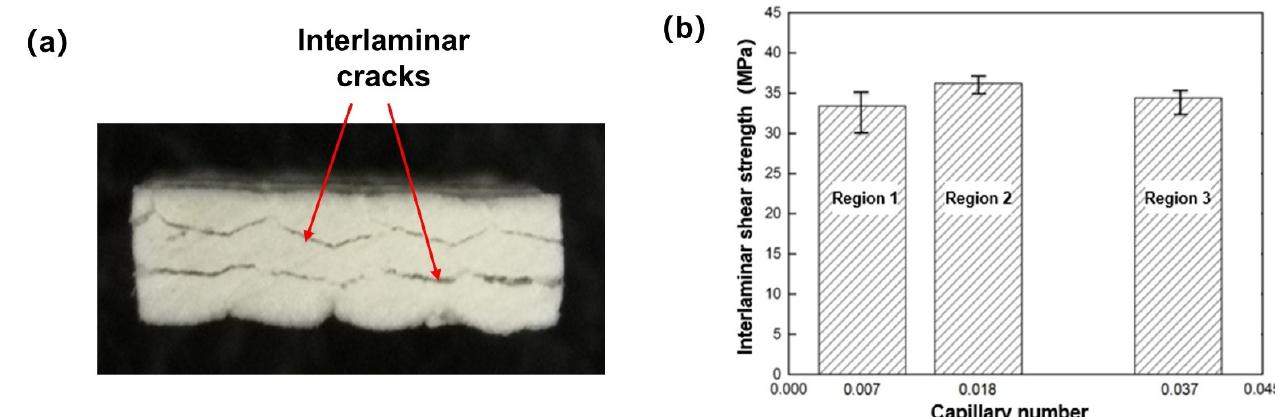
Figure 15. ( a ) Delaminated samples after ILSS test. ( b ) Influence of capillary number on interlaminar shear strength.